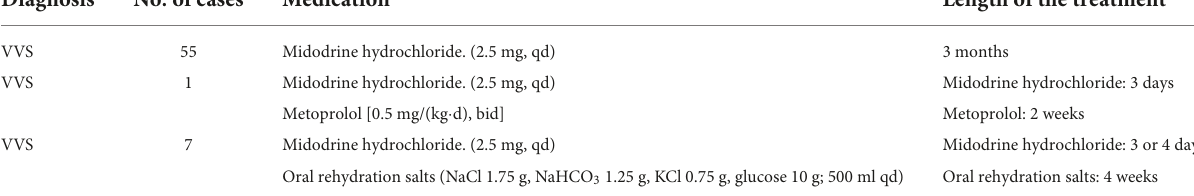
TABLE 1 Treatment of patients with